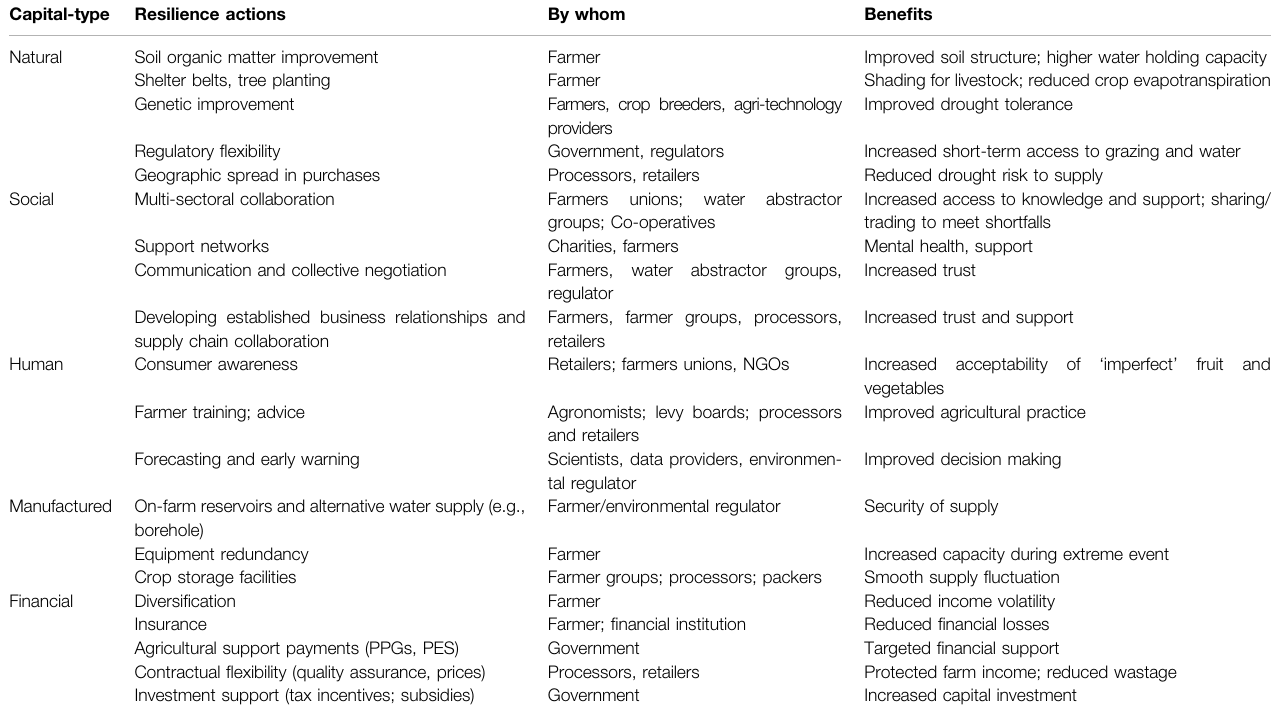
TABLE 3 | Mapping resilience actions by different stakeholders to increasing the fi ve capitals. Capital-type Resilience